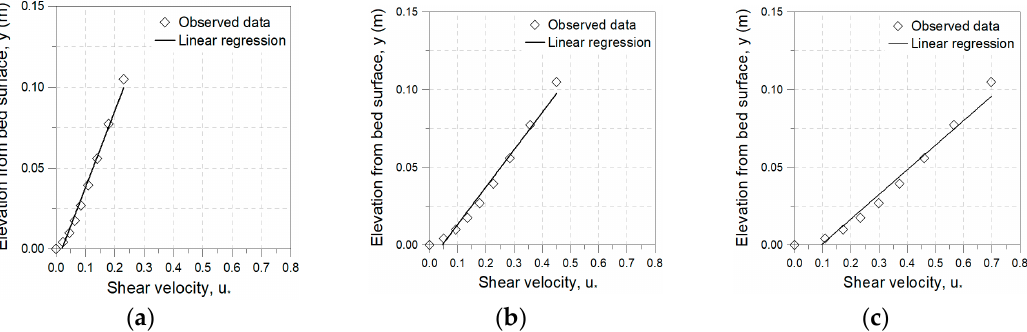
Figure 7. Representative distribution of shear velocity for soil slurry of 0.5 mm particle diameter; ( a )